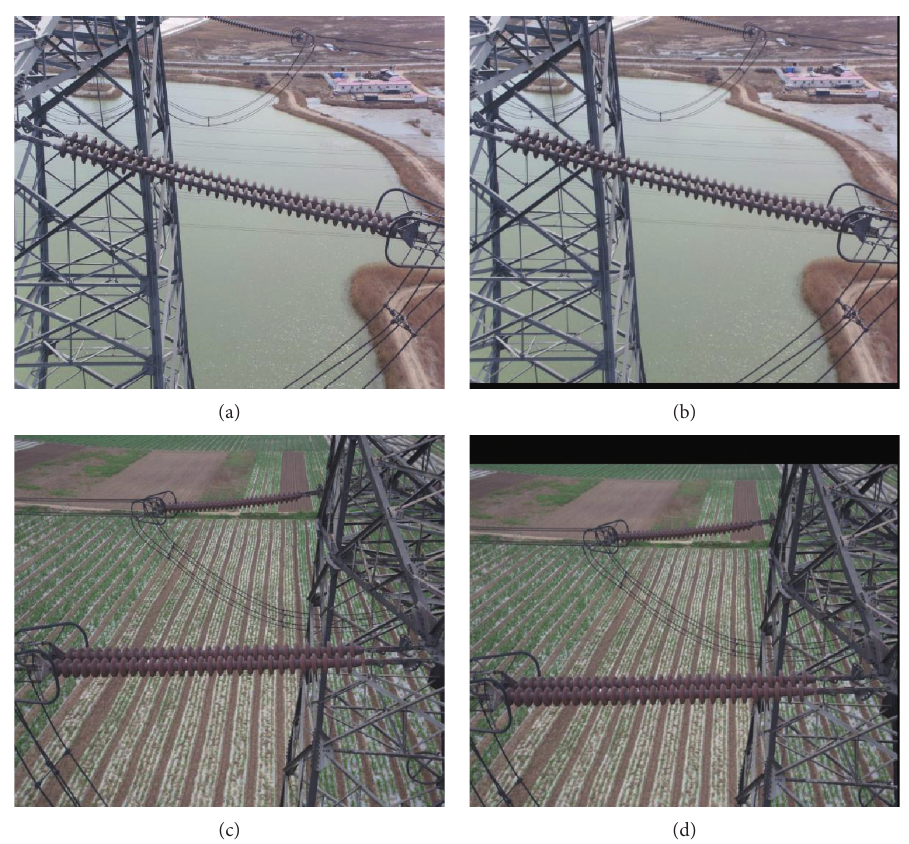
Figure 4: Images before and after random